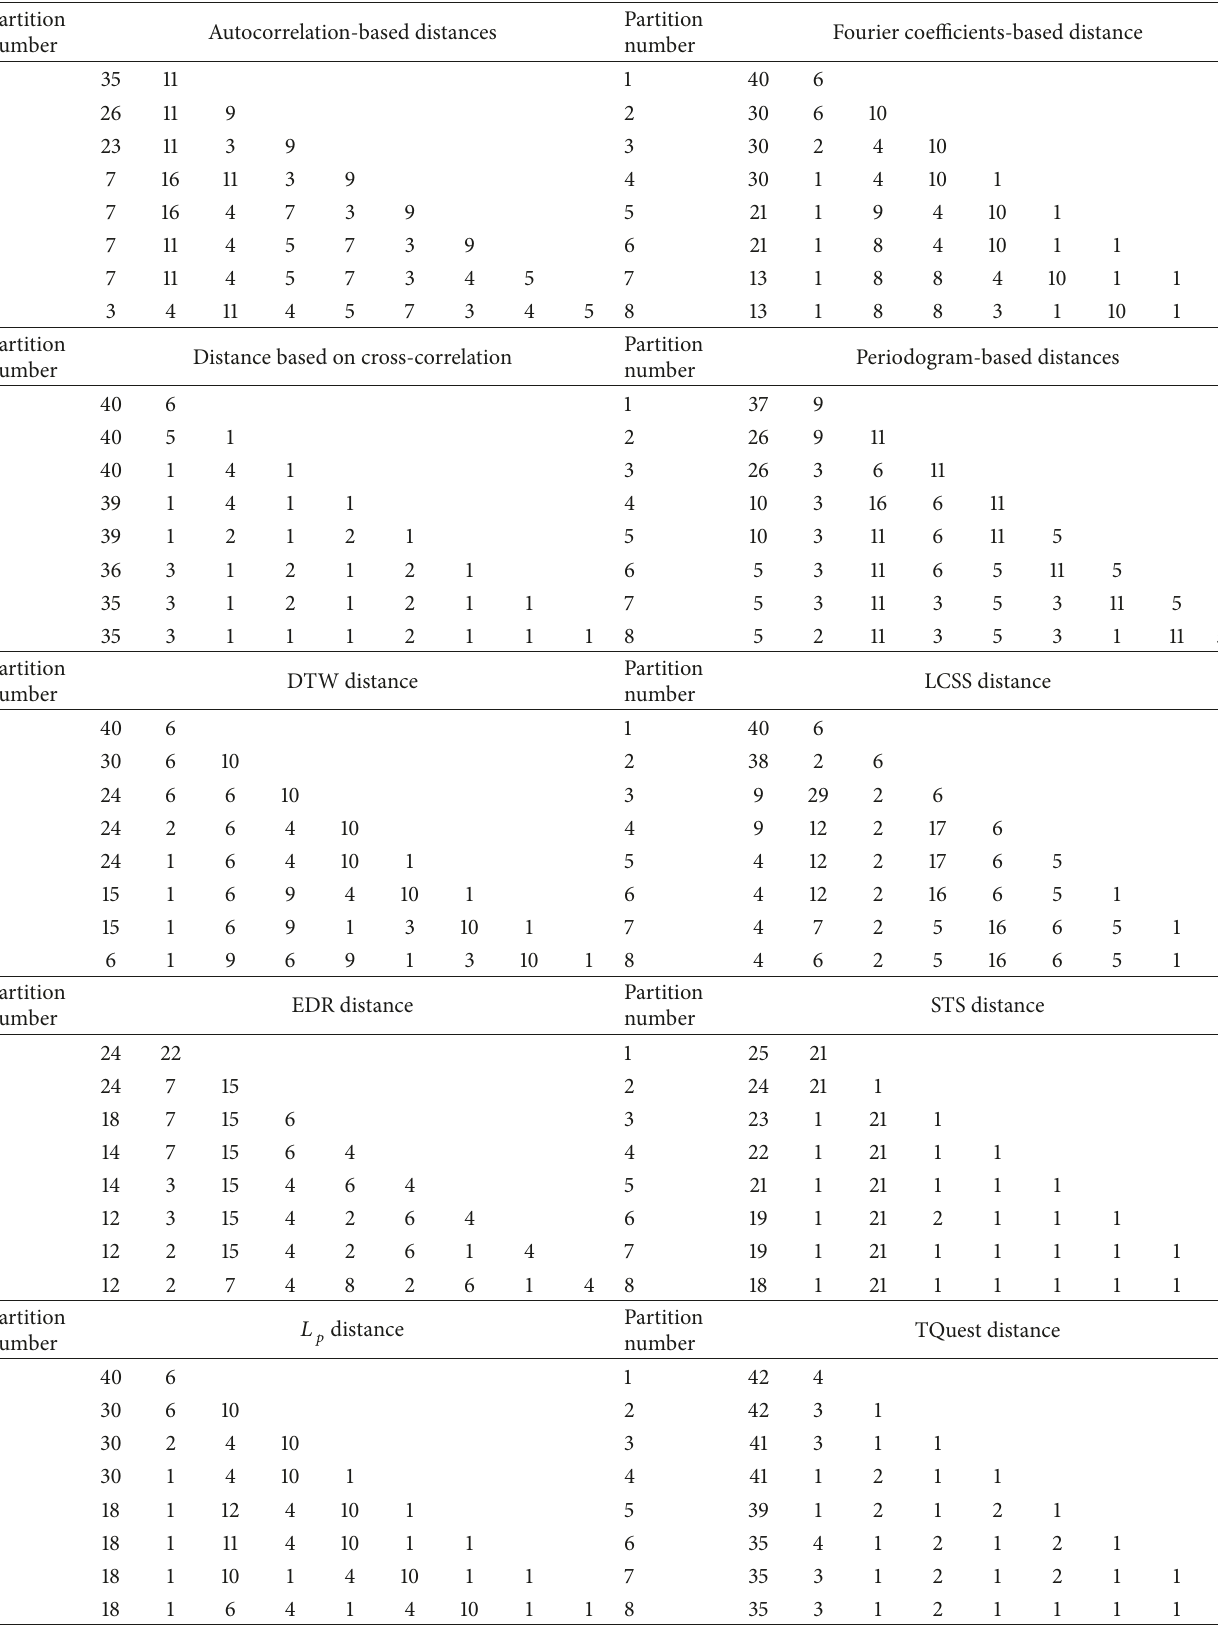
Table 2: Size of each cluster by the type of partition and time series similarity